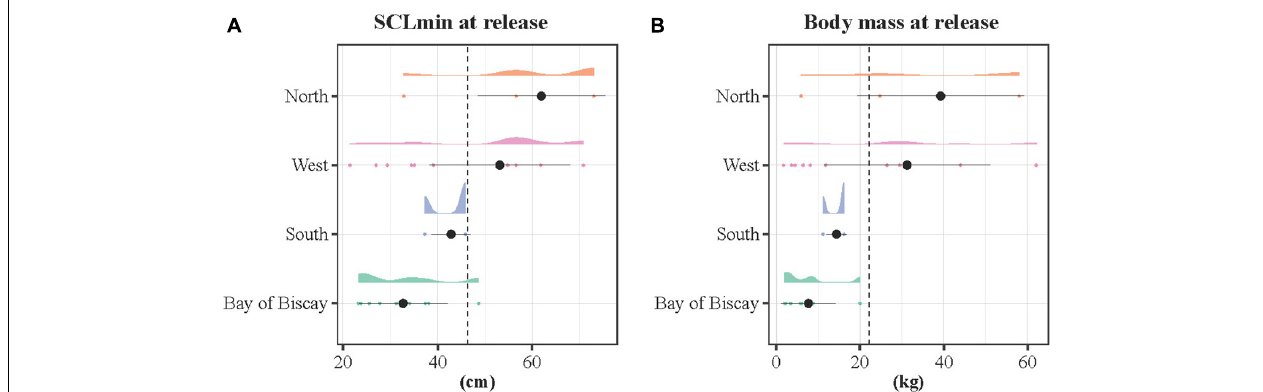
FIGURE 5 | Density distributions of the (A) SCLmin and (B) body mass at release according to the spatial pattern. The density distributions are color-coded by spatial pattern, with a cloud of points below. The dotted lines refer to the average SCLmin and body mass considering the 26 tracked individuals (Francesca was removed because unrepresentative of the sample size). The black dots stand for the mean and the bars the standard deviation for each group.